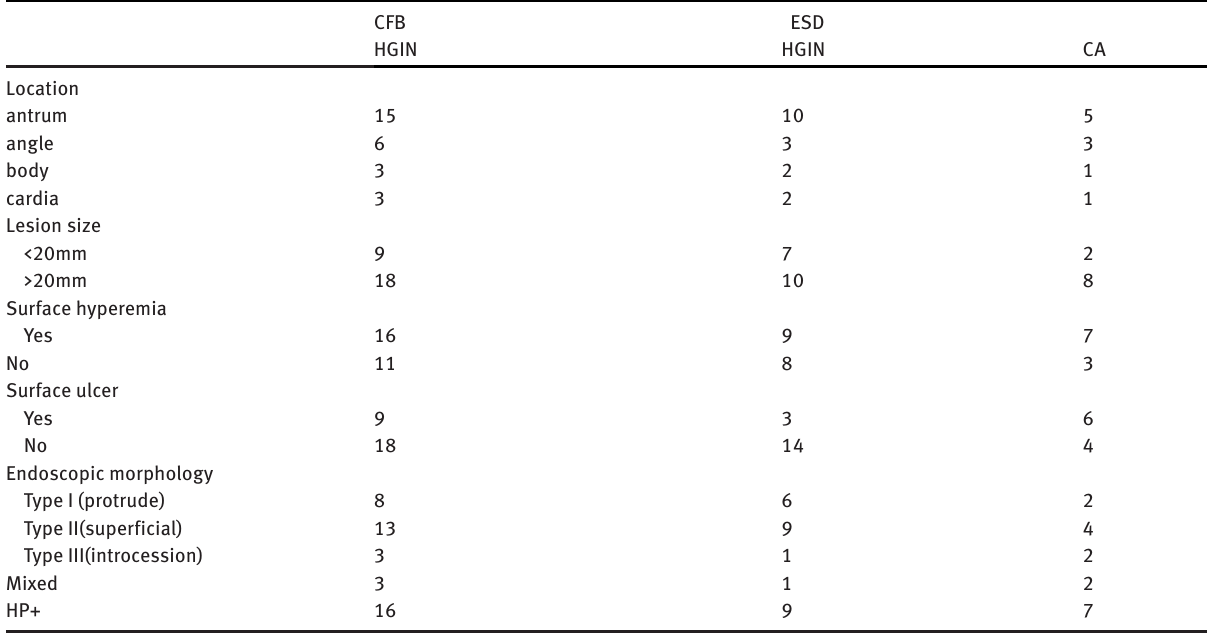
Table 2: Characteristic of 27 HGIN patients under CFB CFB ESD HGIN HGIN